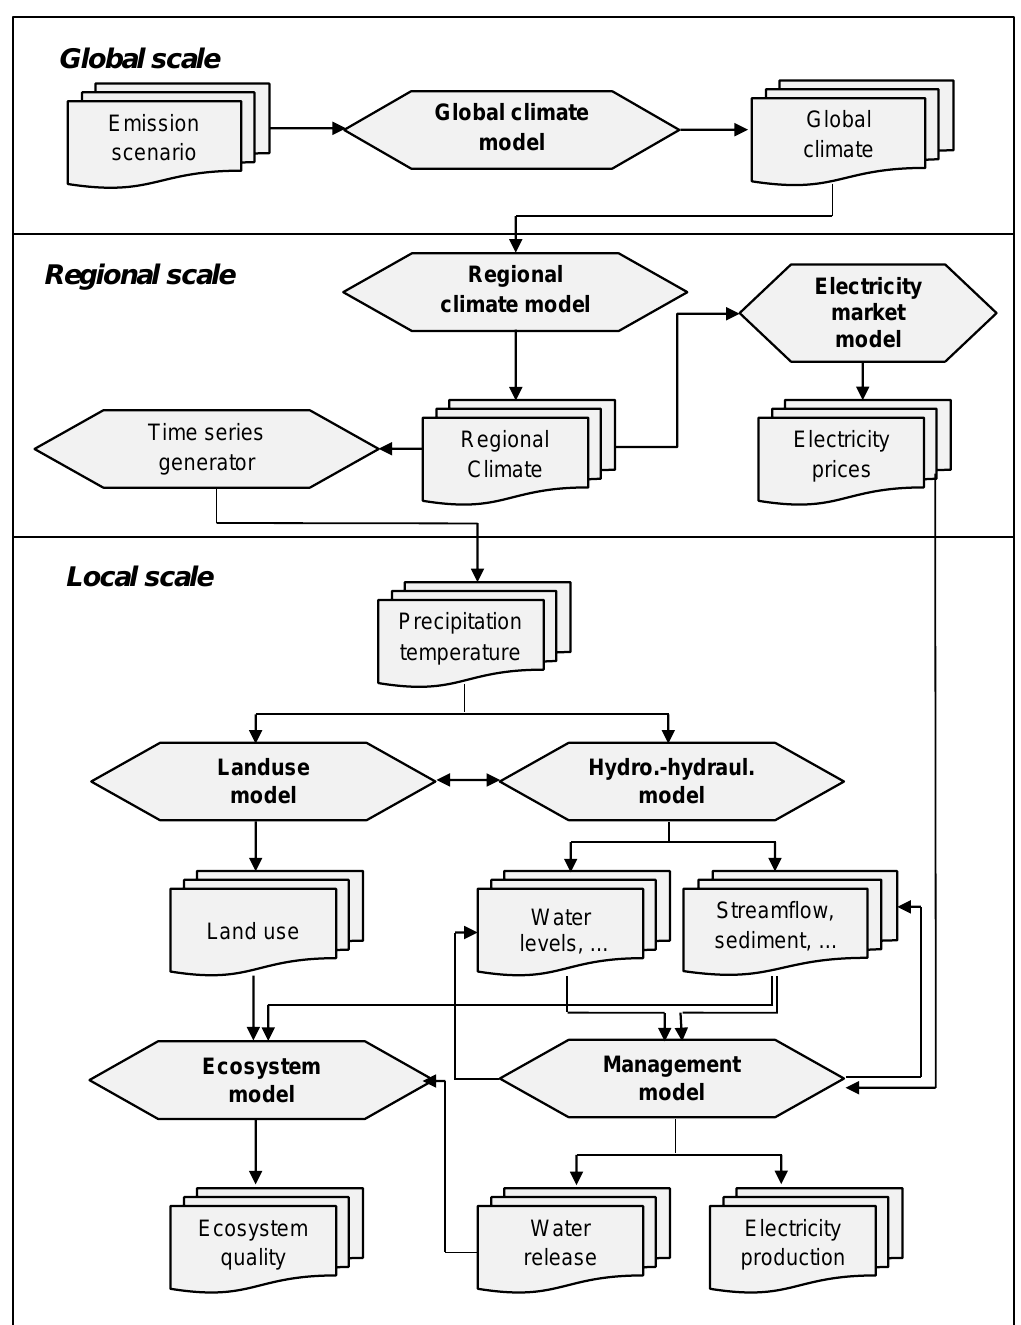
Figure 2. Scheme for simulating the impact of climate change from Schaefli